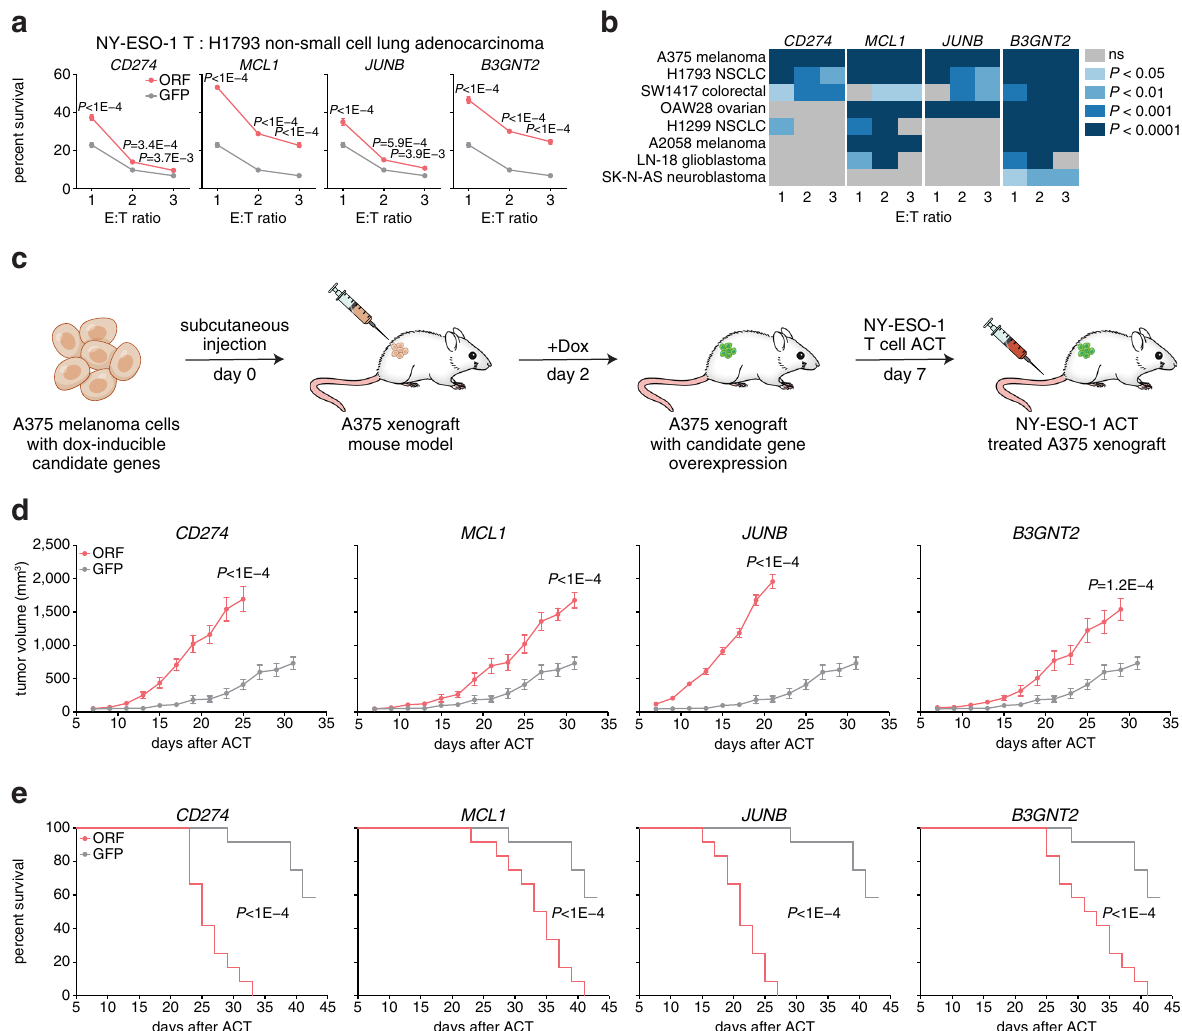
Fig. 2 Candidate gene overexpression mediates resistance in other cell types and in vivo. a Cell survival against ESO T cell cytotoxicity of H1793 (NY- ESO-1 + , HLA-A2 − ) non-small cell lung adenocarcinoma transduced with HLA-A2 and ORFs encoding candidate genes. N = 12. Two-tailed t tests with adjustments for multiple comparisons were performed. b Heatmap summarizing results from ESO T cell cytotoxicity assays for eight cell lines derived from different tissues. Each value represents the signi fi cance of the difference between the survival of each ORF and GFP control. Two-tailed t tests with adjustments for multiple comparisons were performed. c Schematic of the in vivo experiments to test the response of A375 xenografts overexpressing candidate genes to adoptive cell transfer (ACT) in NSG mice. d , e Tumor growth in mice receiving ACT of ESO T cells. Data are representative of two independent experiments. N = 12. d Tumor volume is shown. Two-tailed t tests with adjustments for multiple comparisons were performed. e Overall survival is shown. Mantel – Cox log-rank tests were performed. All values are mean ± s.e.m. Source data are provided in Source Data